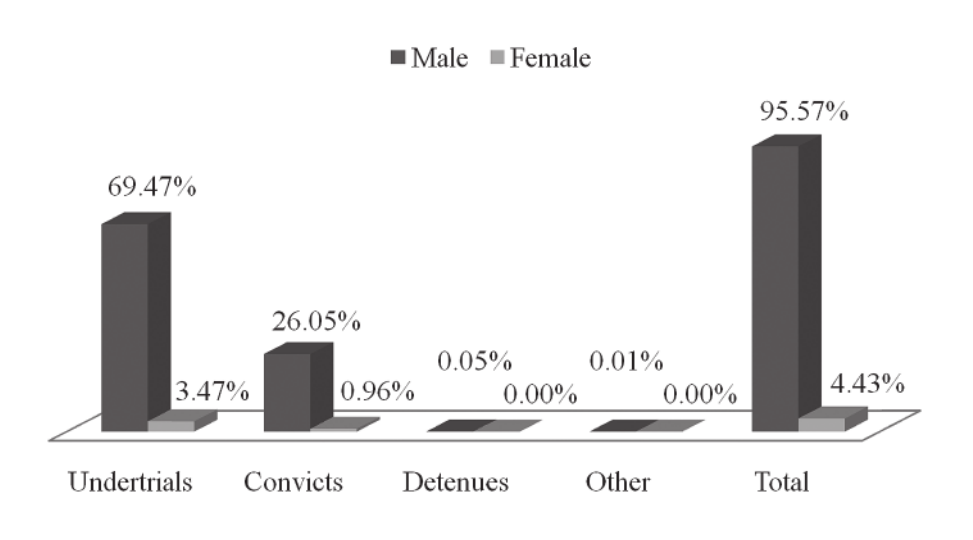
Figure 1 Classification of inmate population as at 30 June 2012 Source: Government of NCT of